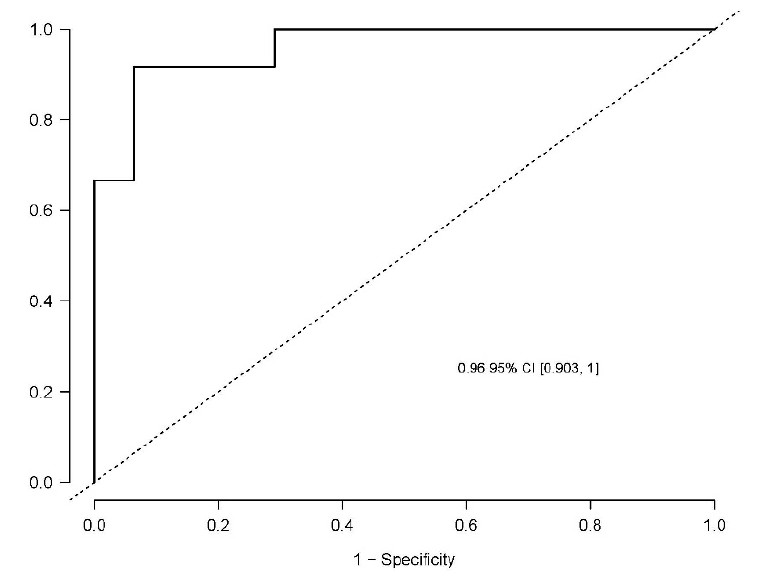
Figure 4. Receiver operating characteristic curve for the diagnostic model. The area under curve (AUC) is 0.96 (95% Confidence interval (CI), 0.903–1).